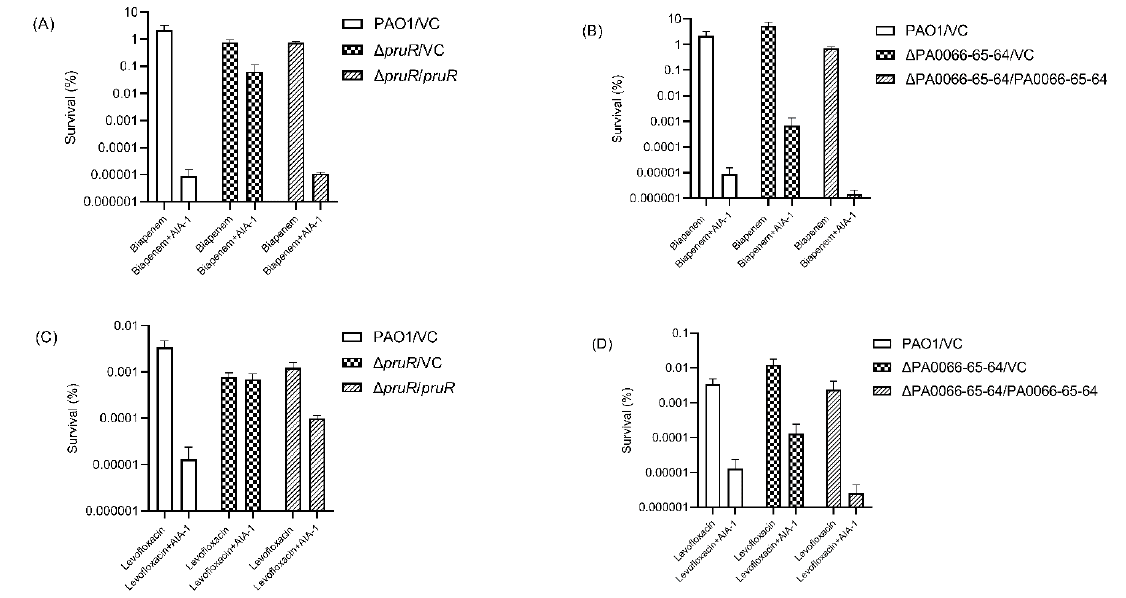
Figure 3. Killing assay with antibiotics and AIA-1 on complemented strains. Killing effect of biapenem and AIA-1 on ( A ) ∆ pruR / pruR , ∆ pruR vector control, and PAO1 vector control, and ( B ) ∆ PA0066-65-64/PA0066-65-64, ∆ PA0066-65-64 vector control, and PAO1. Killing effect of levofloxacin and AIA-1 on ( C ) ∆ pruR / pruR , ∆ pruR vector control, and PAO1 vector control, and ( D ) ∆ PA0066-65-64/PA0066-65-64, ∆ PA0066-65-64 vector control, and PAO1. Error bars show SD for